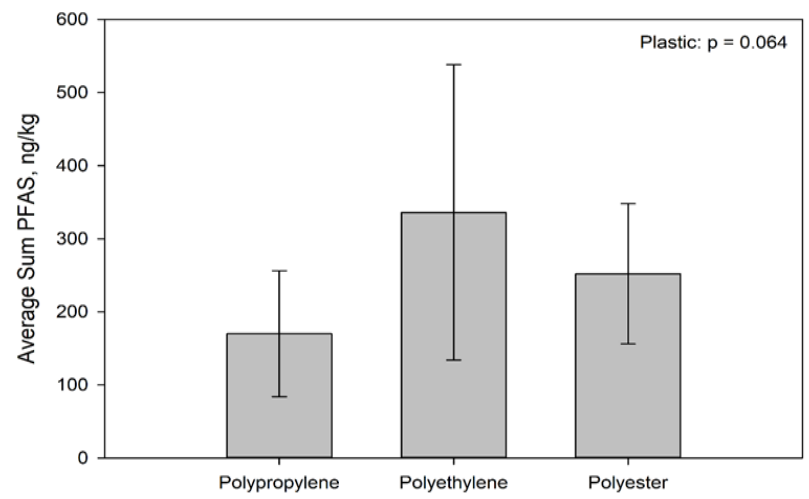
Figure 2. Average Sum of 7 PFAS (ng/kg) by Plastic Types for Materials Deployed in Muskegon Lake, MI for 1 Month and 3 Month Incubations in the Environment. The concentrations of PFAS associated with the deployed microplastics by location and time are presented in Figures 3–5 for polyethylene, polypropylene, and polyester, respectively. On polyethylene (Figure 3), PFAS concentrations were not significantly different among sites at 1 month but were significantly different at 3 months due to concentrations on the plastics at the channel water column site exceeding those at both the channel bottom and lake bottom sites. On polypropylene (Figure 4), only time had a significant effect on PFAS concentration, with the 1 month concentrations greater than the 3 month concentrations; neither site nor the interaction term were statistically significant. Finally, on polyester (Figure 5), PFAS concentrations were not significantly affected by time or site.